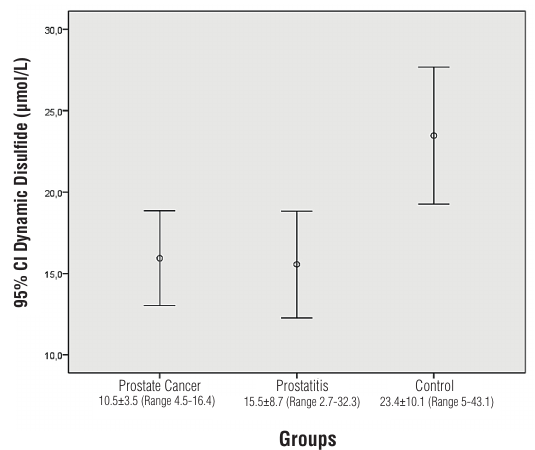
Figure 3 - Comparison of Dynamic Disulphide